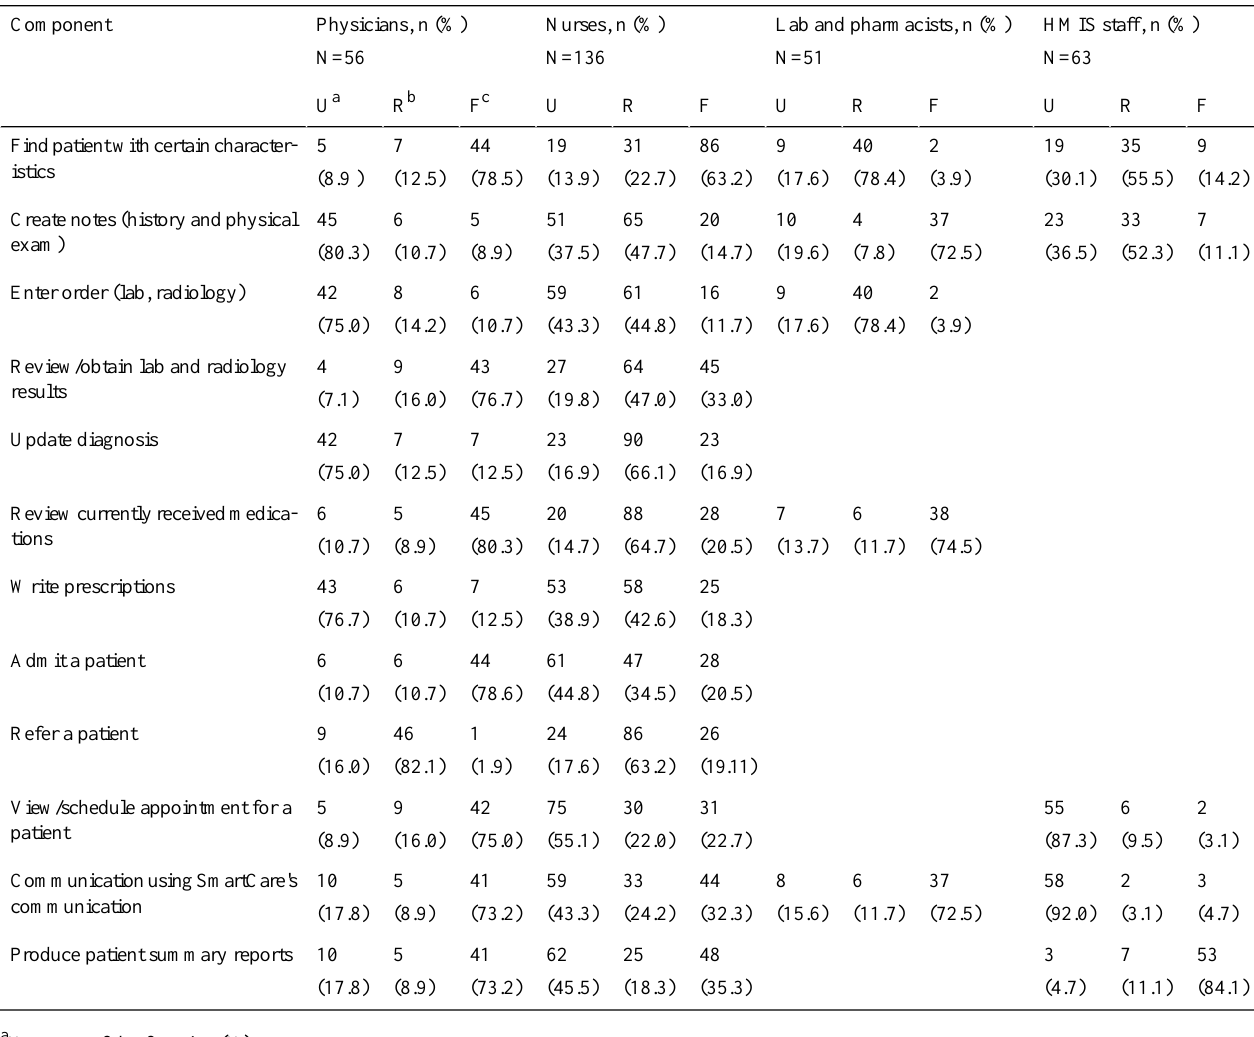
Table 4. Use of the basic EMR components